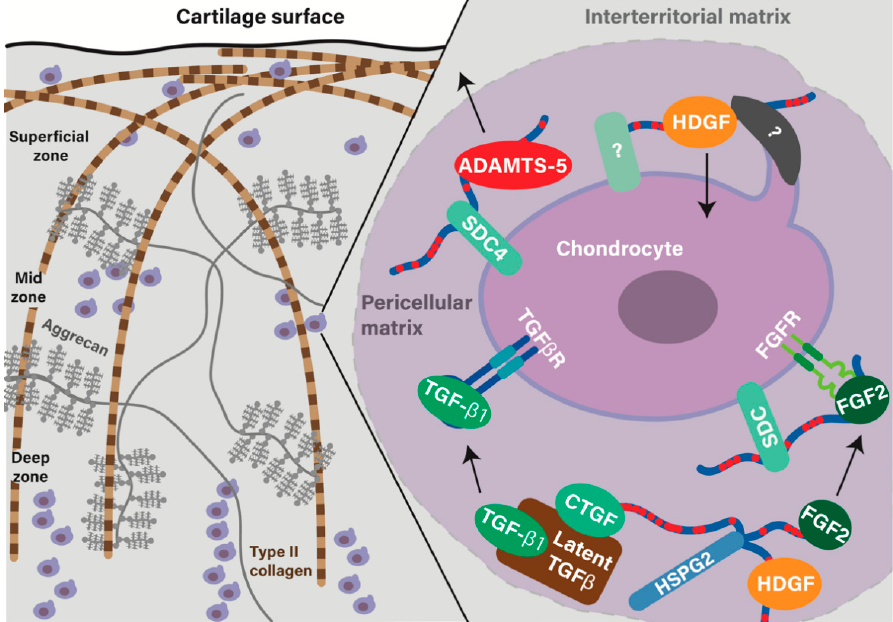
Figure 2. Schematic view of the cartilage extracellular matrix, highlighting the role of the pericellular matrix in chondrocyte signaling. Triple-helical type II collagen associates with type XI and type IX collagen (not shown) to form fibrils that extend through the territorial and interterritorial matrices of cartilage, ascending vertically from the deep zone, and becoming parallel with the cartilage in the superficial zone. Aggrecan, with its numerous negatively charged chondroitin sulfate GAG chains, draws sodium and water into the tissue. Together, these two macromolecules give cartilage its me- chanical properties. Chondrocytes make up between 5–10% of the volume of cartilage. Immediately surrounding the chondrocyte is a pericellular matrix (right, purple shaded region), which is en- riched in type VI collagen (not shown) and the heparan sulfate proteoglycan, perlecan. Perlecan sequesters a number of bioactive molecules including growth factors. Upon release, FGF2 binds to